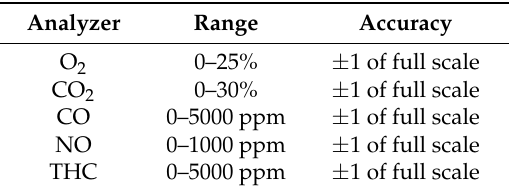
Table 3. Basic parameters of gas engine. THC: Total